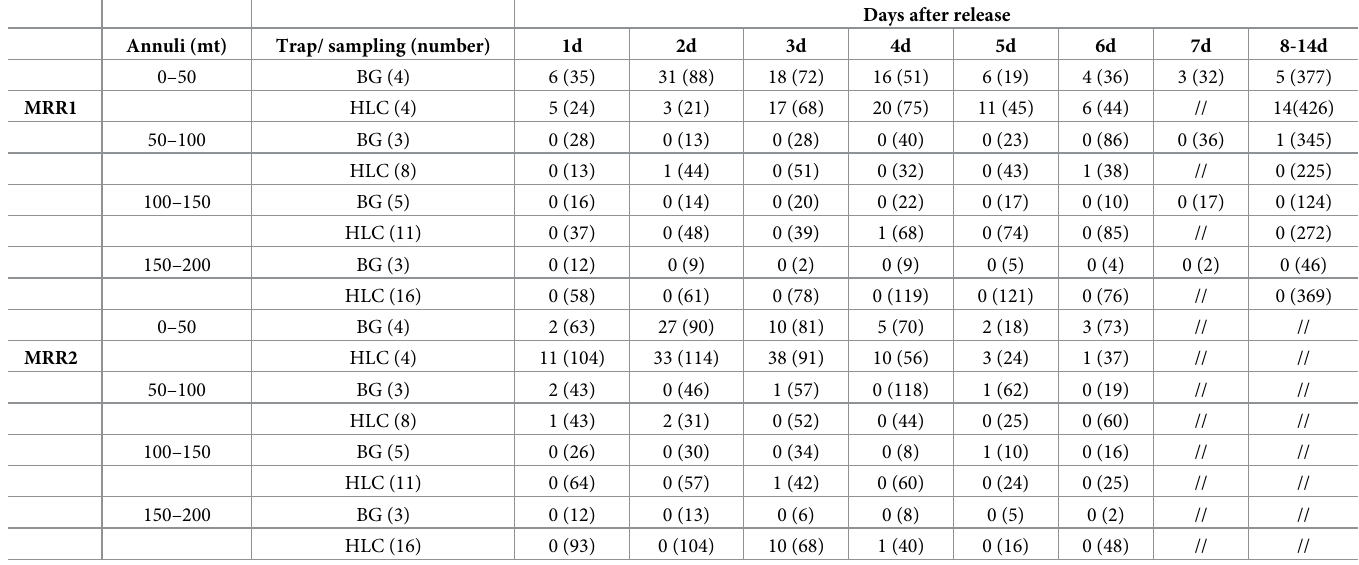
Table 3. Number of marked (and unmarked) Ae . albopictus males recaptured in two Mark-Release-Recapture (MRR) experiments on Procida Island. BG = BG-sen- tinel traps (number of BG within each annulus); HLC = Human Landing Catches (number of HLC sites within each annulus).